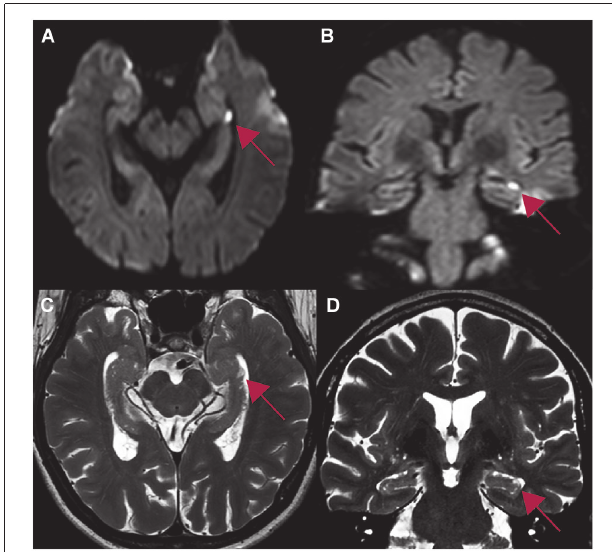
FIGURE 4 | Whole brain 3T MR-imaging of one patient showing a focal lesion in the head of the left hippocampus in CA1 (red arrow) after an emotional stressful event . The lesion in the diffusion-weighted imaging (A,B) correlates with the lesion in T2-weighted sequences (C,D) . Table 1 : Study 2: demographic data, precipitating events and distribution of hippocampal lesions. Ant, anterior; post,